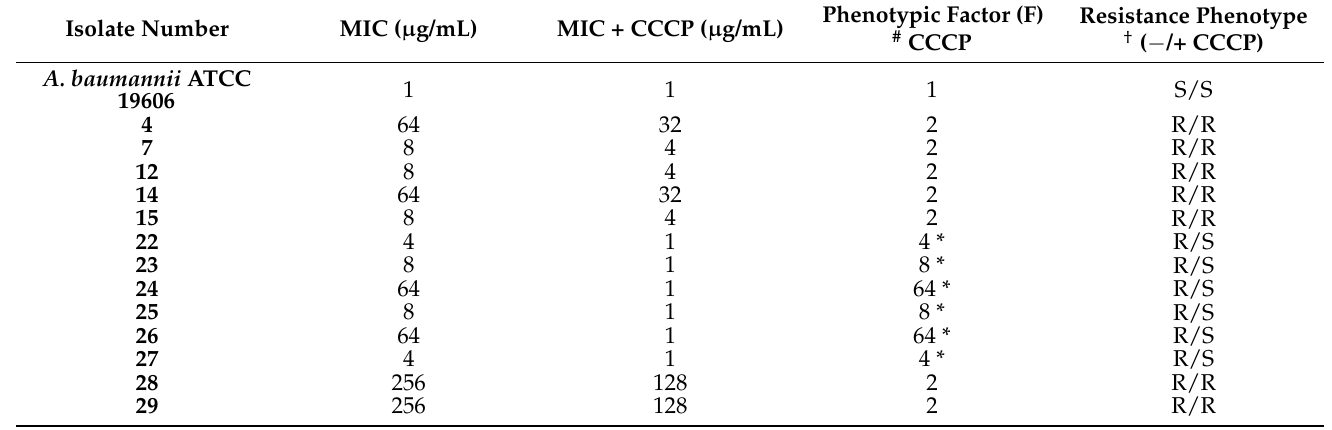
Table 2. Change in the phenotypic resistance pattern of isolates to levofloxacin under the effect of